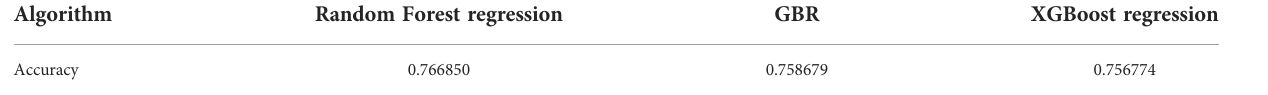
TABLE 5 Final prediction accuracy.